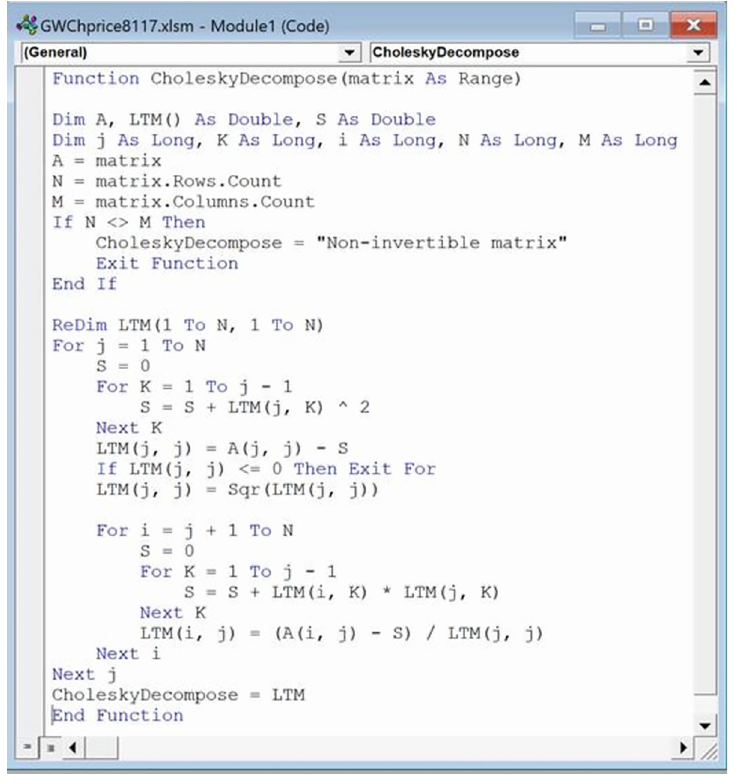
Fig 6. Cholesky decomposition in Excel